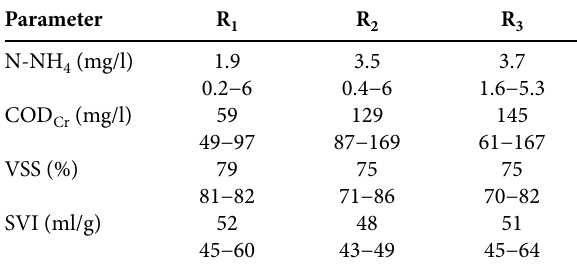
Table 3. Average effluent concentrations and their range for refer- ence model R 1 , model R 2 with glucose and industrial wastewater, and model R 3 with only industrial wastewater